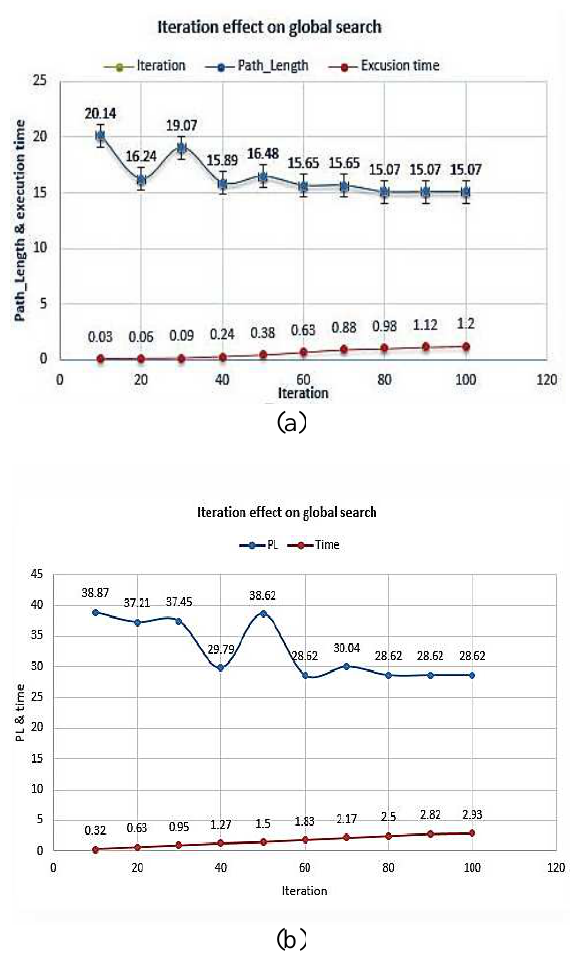
Fig. 7. Effect of no of iteration andexecution time for 10 map.